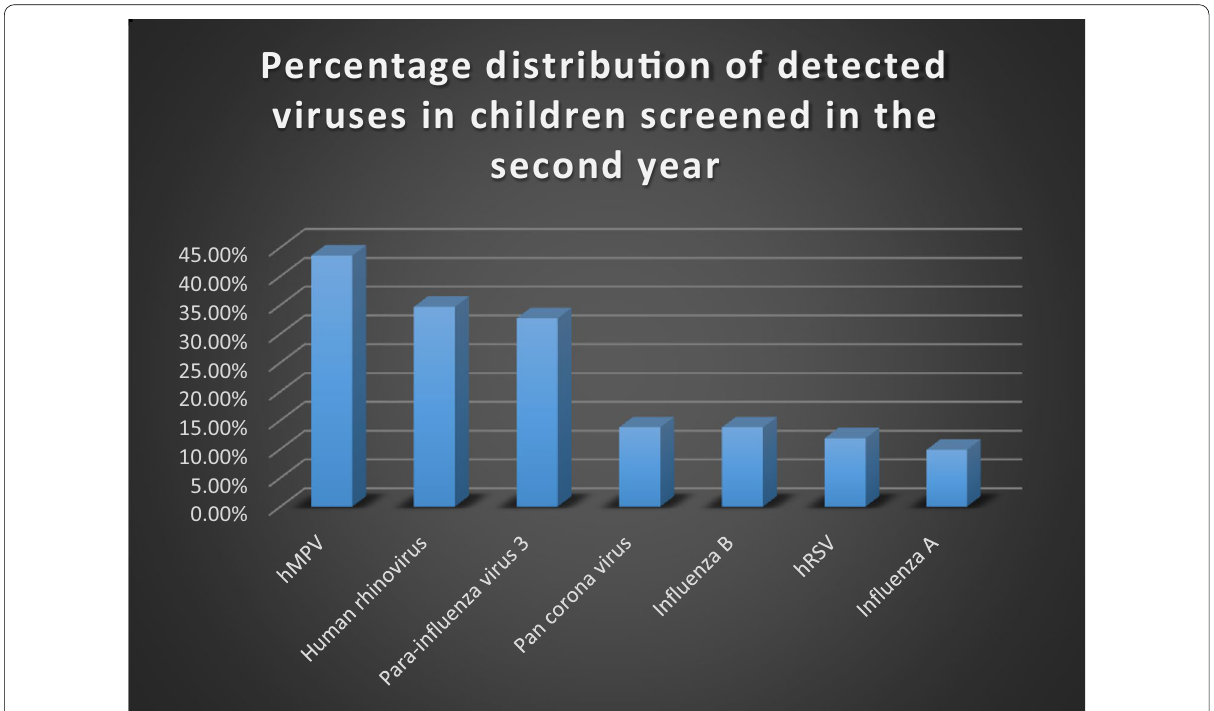
Fig. 1 Percentage distribution of viruses detected in children screened in the second year